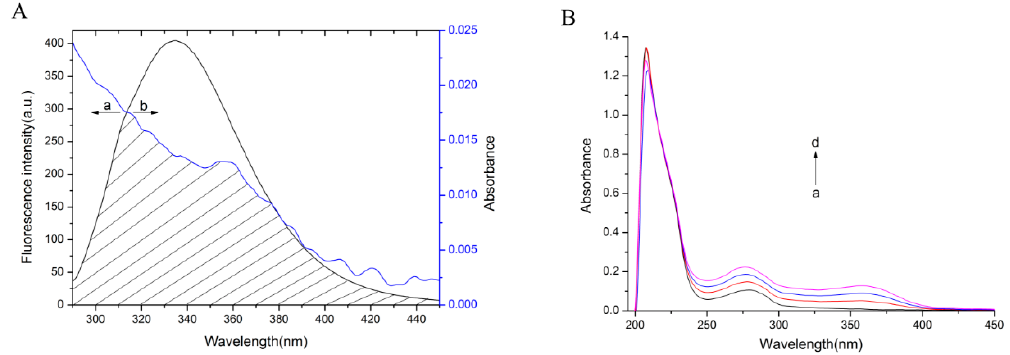
Figure 2. ( A ) Spectral overlaps of the fluorescence spectra of bLf with the absorption spectra of TCH. ( B ) UV-vis absorption spectra of bLf without and with TCH. Table 3. The binding parameters of TCH binding with bLf at 300 K.